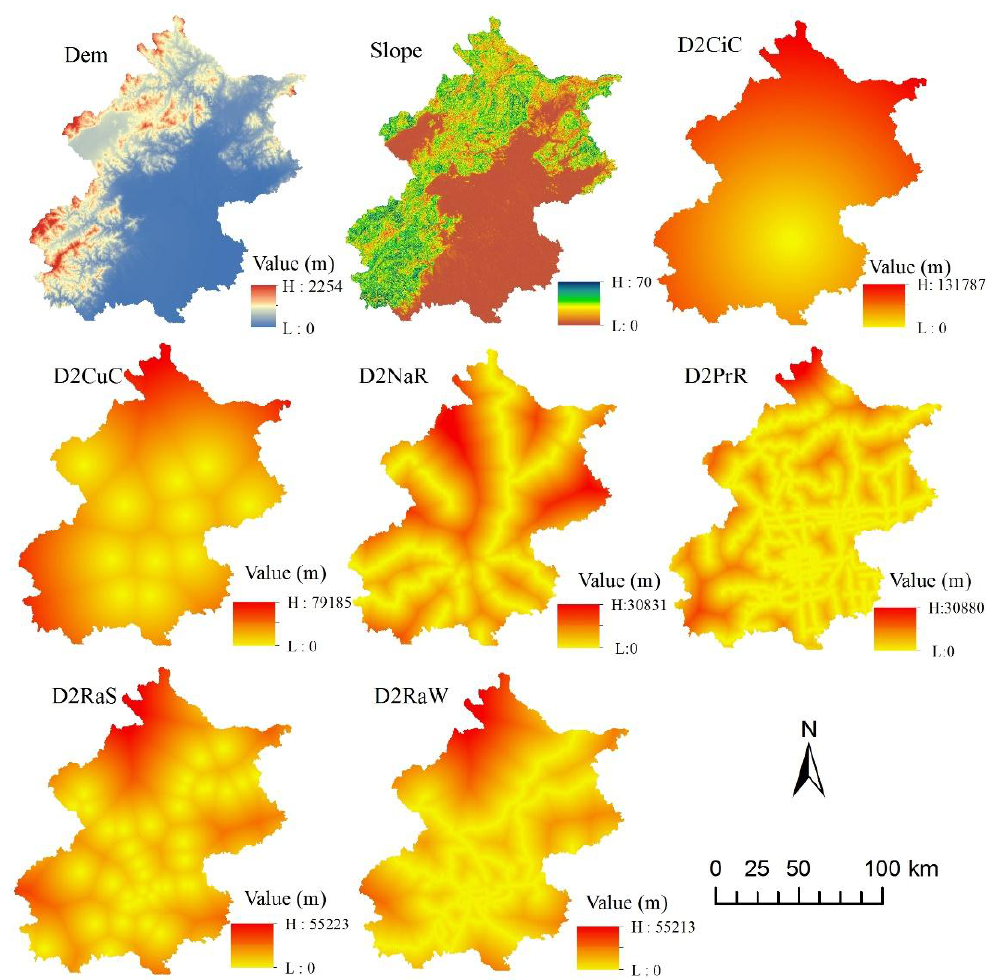
Figure 3. The spatial distribution of the selected driving factors for 1984–1990.